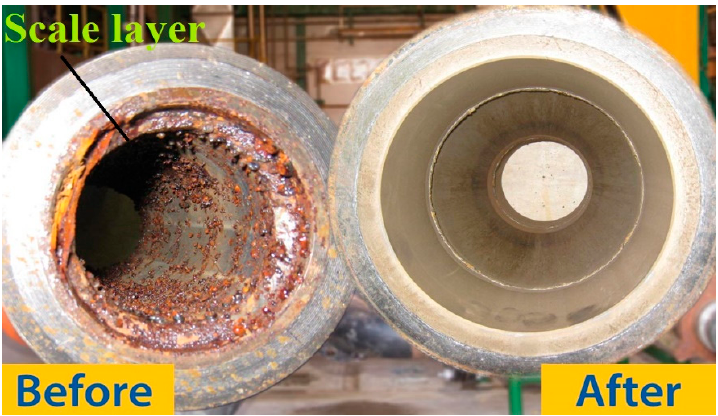
Figure 1. An oil pipeline before and after cleaning of the scale layer by chemical methods [26]. When the scale layer is compared to the fluid flow inside the oil pipeline, its